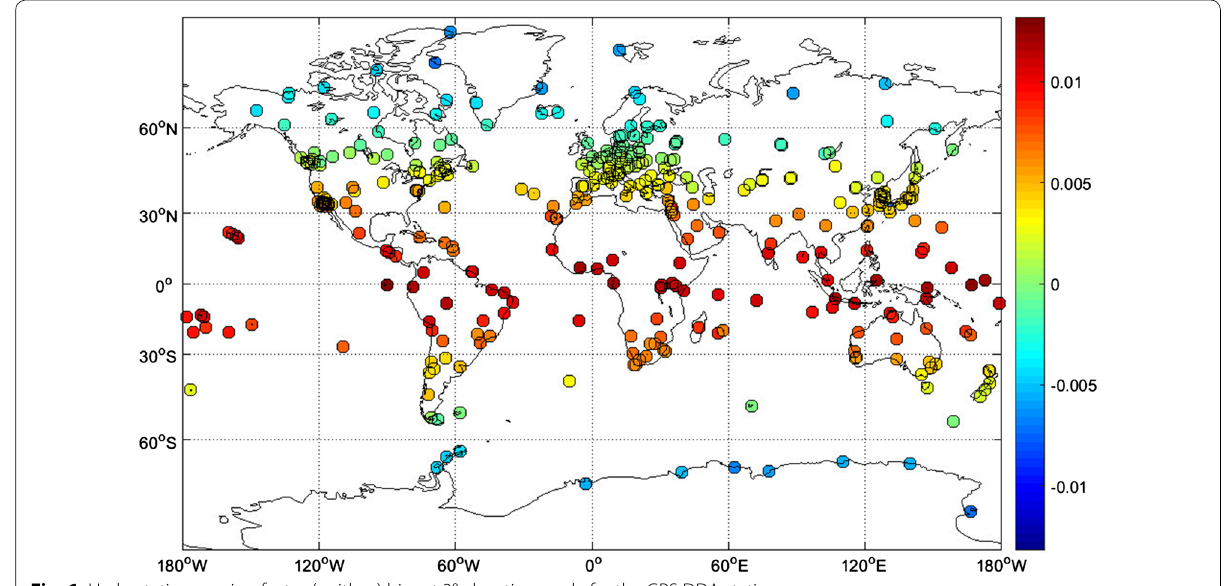
Fig. 6 Hydrostatic mapping factor (unitless) bias at 3° elevation angle for the GPS DDA stations